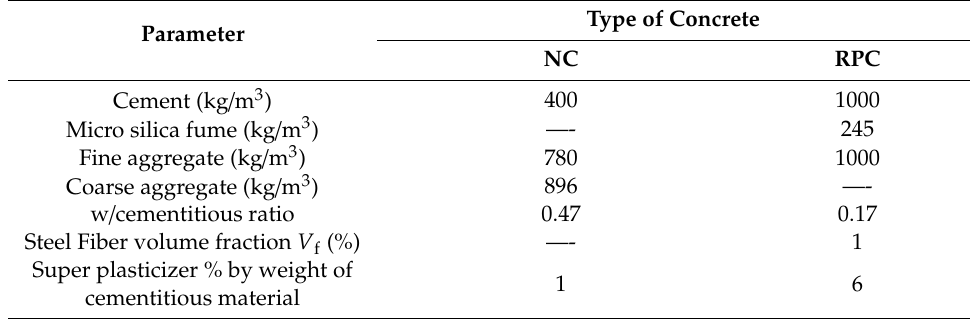
Table 3. Properties of normal concrete (NC) and reactive powder concrete (RPC) mixtures.